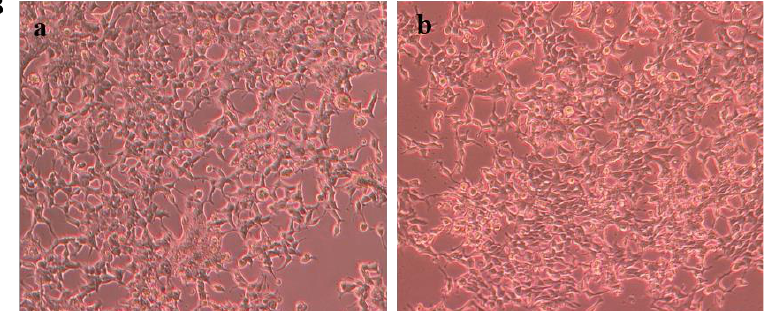
Figure 7. ( A ) Effect of Linalool on HEK cells. HEK cells treated with different concentrations of Linalool showed 100% viability at the tested concentrations. Data are represented as S.D. ( B ) Effect of Linalool on HEK (Human Embryonic Kidney) cells. ( a ) Control HEK cells ( b ) HEK cells treated with Linalool (0.004%) were healthy and normal compared to the control.